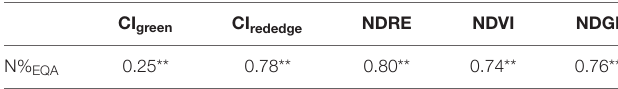
**Correlation is significant at the 0.01 level